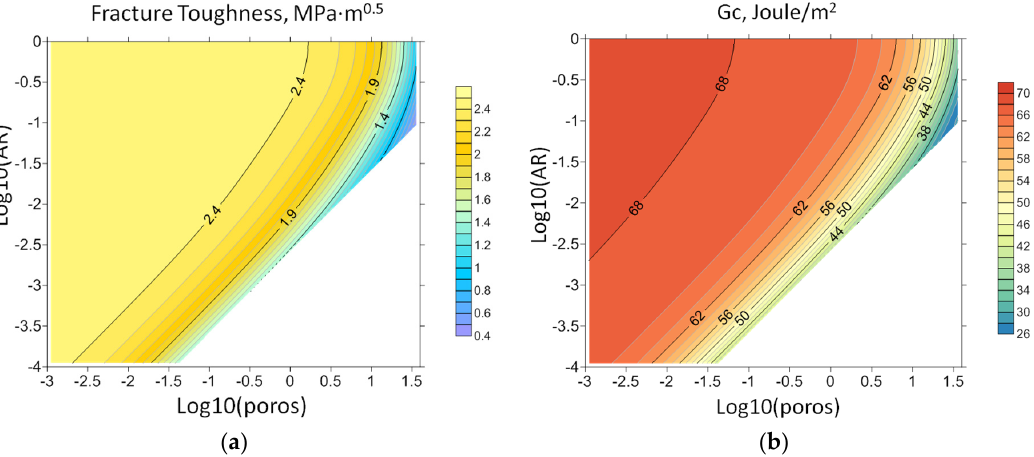
Figure 8. ( a ) Fracture toughness and ( b ) critical strain energy release G C versus decimal logarithms of porosity and void’s aspect ratio.